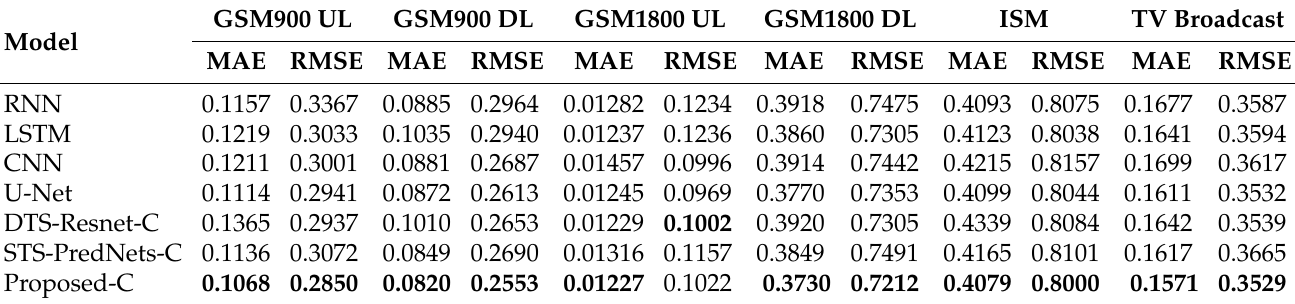
Table 2. Prediction performance of different frequency bands on Aachen open dataset.